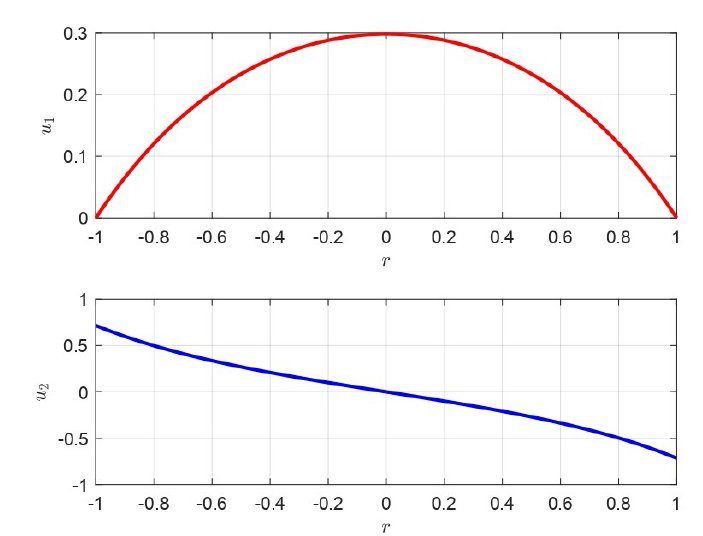
Figure 2. Recovering of the membrane by using the bvp4c MatLab R (cid:13) solver: θλ 2 = 0.5, u 1 ≤ 2.446, u 2 = 0.